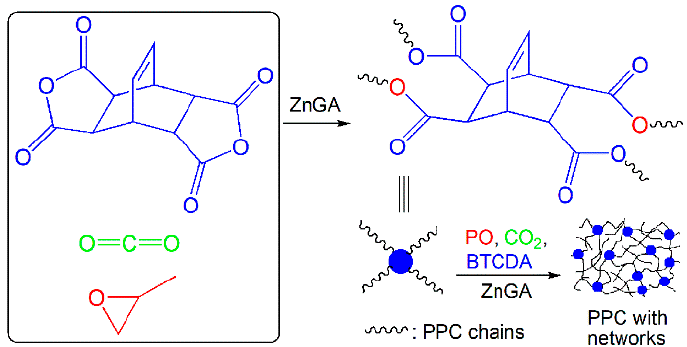
Table 1. The results of yields and gel contents of PPC and PPC with